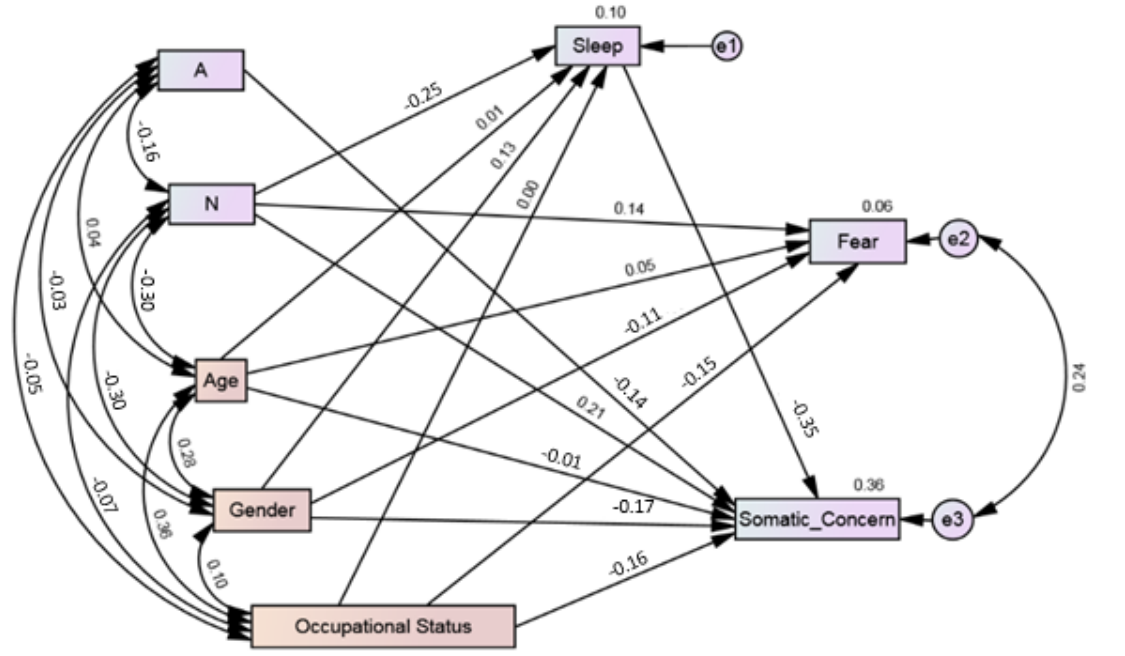
Figure 2. Path analysis model (M2) demonstrating the relationship between personality traits (A: Agreeableness; N: Neuroticism) and COVID-19 pandemic anxiety mediated through sleep quality. Note: The covariance between personality traits was assumed. Age, gender, and occupational status were included as control variables in the model.